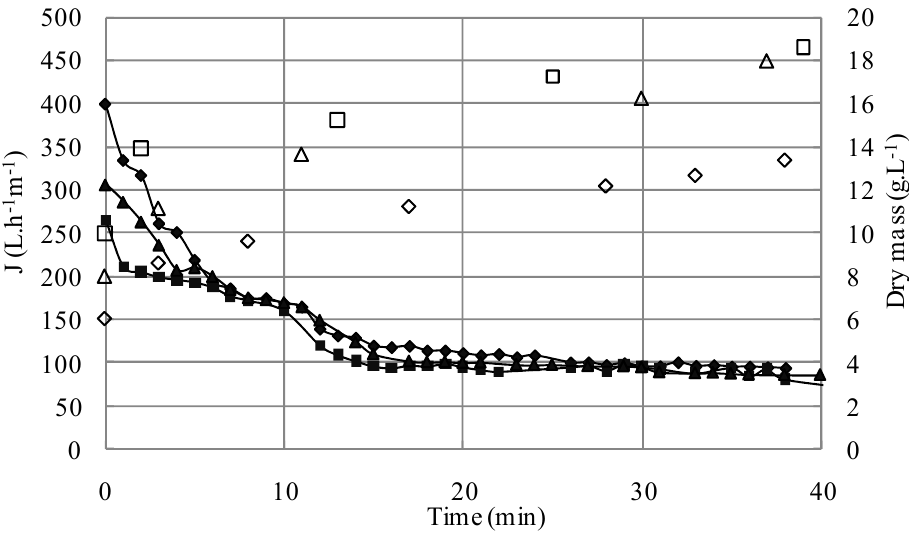
; ▲ S ; ■ S ) on microfiltration performance 1 4 5 ; Δ S ;  S ) versus time (TMP = 1.5 bar, 1 4 5